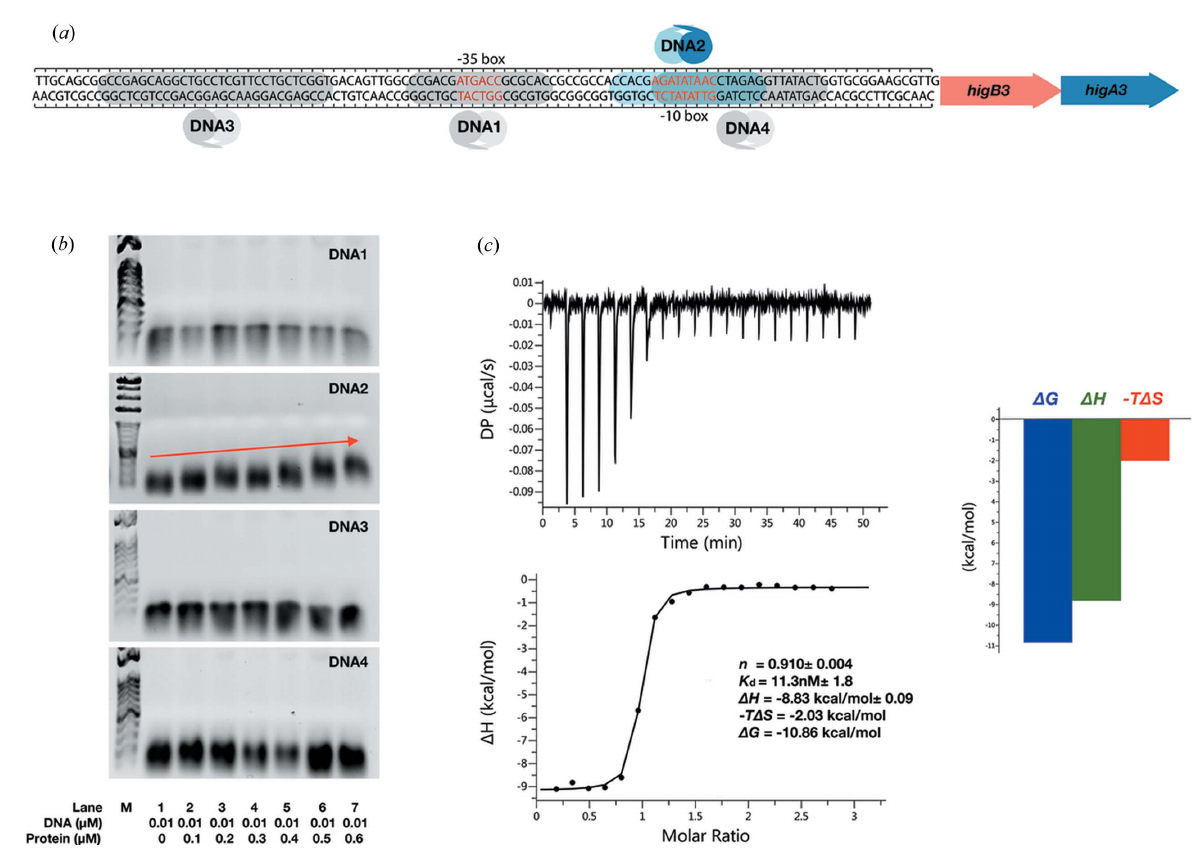
Figure 3 Mt HigA3 binds to the higBA3 promoter region at a specific sequence. ( a ) Organization of the higBA3 operon. The higB3 toxin gene is located upstream of the higA3 antitoxin gene. Two putative operator regions predicted by the BPROM web interface (Solovyev, 2011) located at the (cid:4) 35 and (cid:4) 10 positions are shown in red letters. DNA1, which includes the (cid:4) 35 box, is highlighted as grey, and DNA2, which includes the (cid:4) 10 box, is highlighted in blue. Predicted palindromic sequences (DNA3 and DNA4) for the higBA3 gene are coloured grey. The locations of the higB and higA genes are indicated by red and blue arrows, respectively. ( b ) EMSA experiments of the higBA3 promoter region DNAwith increasing concentrations of Mt HigA3 (0, 0.1, 0.2, 0.3, 0.5 and 0.6 m M ). Only DNA2 is shifted upwards with increasing Mt HigA3 concentration. Band shifts are indicated by red narrows. ( c ) ITC measurement upon the interaction of Mt HigA3 and DNA2. (Left) Graphical representation of thermodynamic parameters for the Mt HigA3 and DNA2 interaction. (Right) Mt HigA3 binding to DNA2 is associated with a favourable entropy